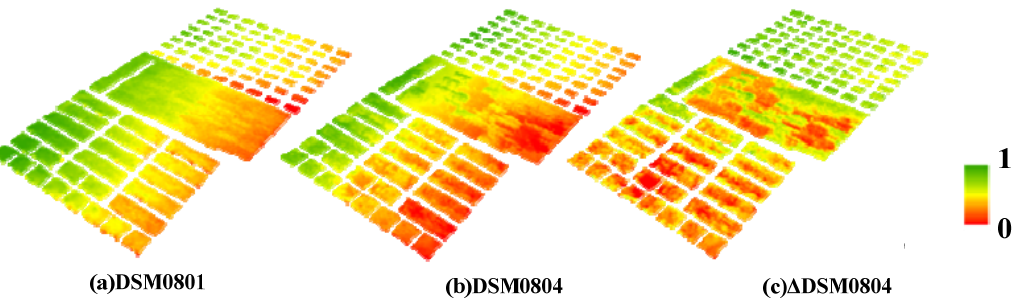
Figure 6. Digital surface model ( a ) before and ( b ) after lodging. ( c ) To eliminate the influence of topography on plant height, the difference between pre-lodging and post-lodging digital surface models is used. The three images are normalized to [0,1] by using the membership ambiguity.